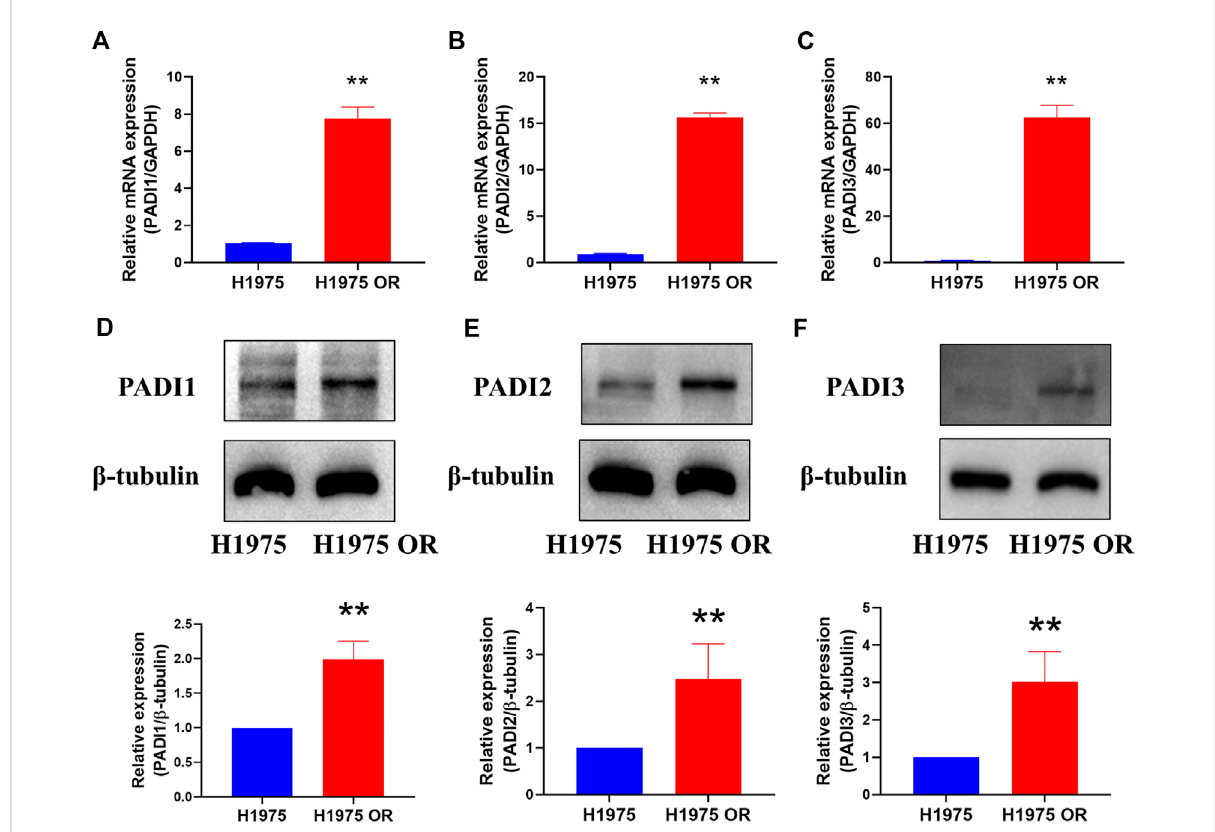
FIGURE 5 PADI1, PADI2, andPADI3werehighly expressedinH1975 ORcells. (A – C) The mRNAexpressions ofPADI1, PADI2, andPADI3 inH1975 cellsand H1975 OR cells were detected by real-time PCR. (D – F) Representative bands of western blots show protein expression of PADI1, PADI2, PADI3, and β -tubulin in H1975 cells and H1975 OR cells. Data are presented as mean ± SD. (** p < 0.01 vs. H1975; n = 3 –